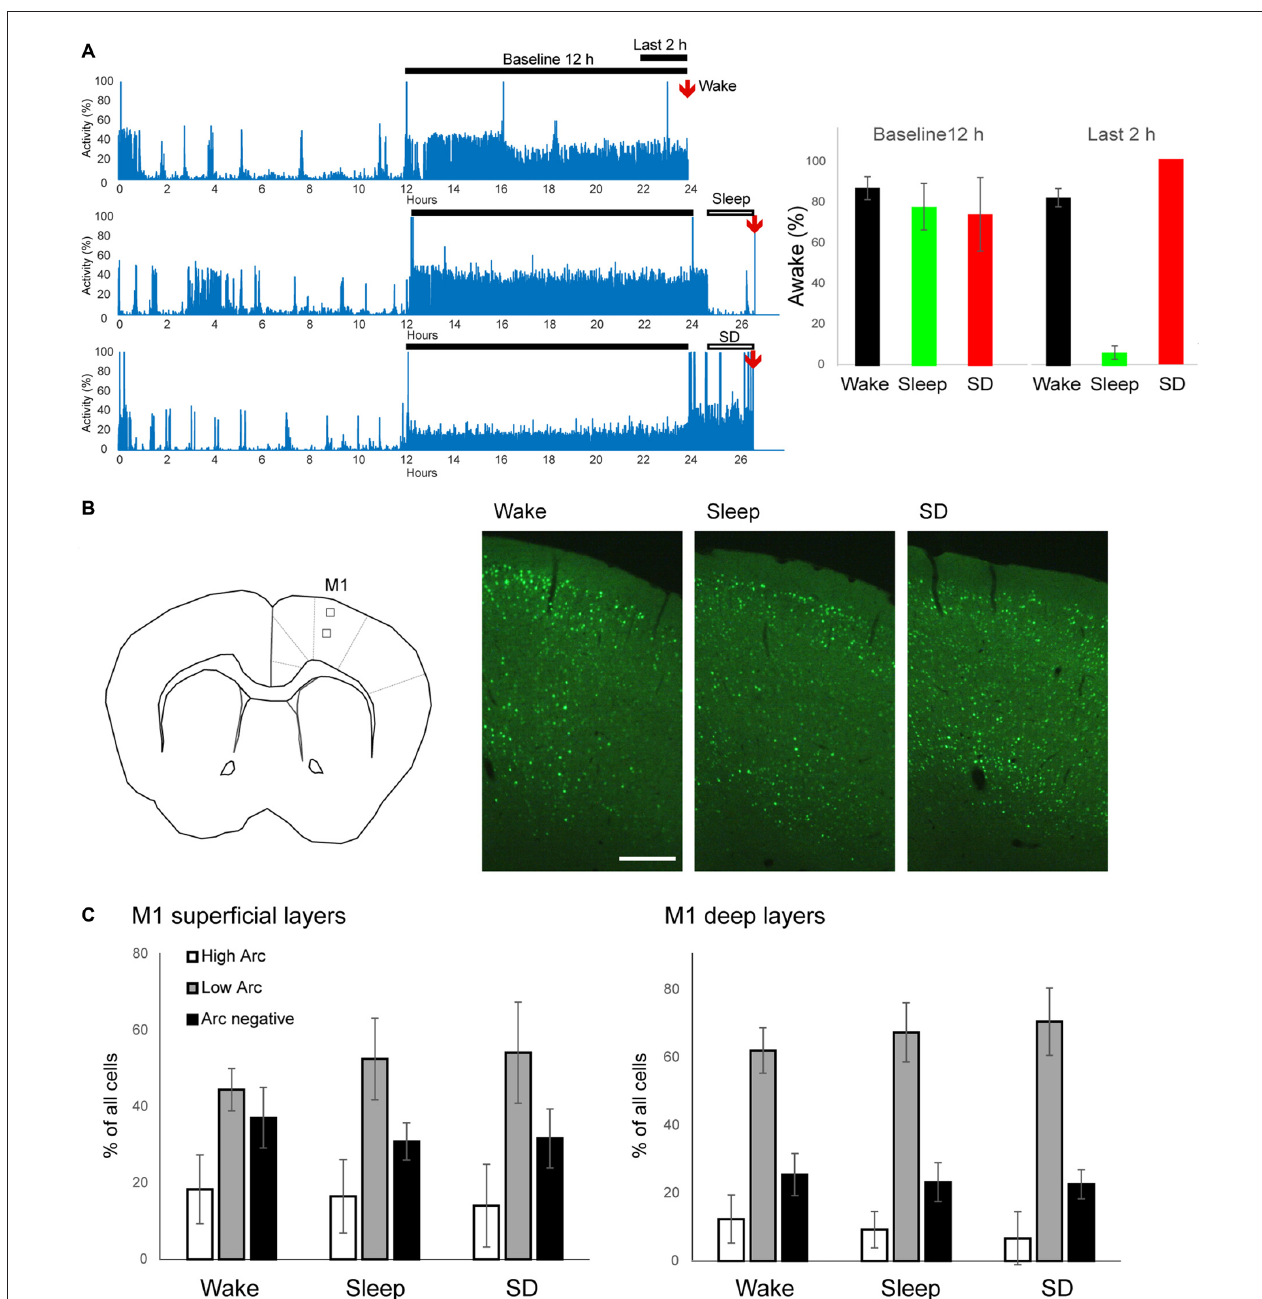
FIGURE 1 | Experimental groups and EGFP-Arc expression in primary motor cortex (M1). (A) Left, representative motor activity recordings in one mouse for each experimental group. Right, quantification of time spent awake during the 12 h of baseline dark phase and during the last 2 h prior to perfusion (6 mice/group). (B) Left, schematic representation of imaging field in superficial and deep layers in M1 (left, square boxes). Right, examples of EGFP-Arc expression in frontal cortex in each experimental condition. Scale bar = 0.25 mm. (C) Quantification of EGFP-Arc expression levels in superficial and deep layers. The percentage of neurons with High Arc expression (white), Low Arc expression (gray) and without Arc expression (black) are shown. Bars and error bars show mean and standard deviation (6 mice/group).